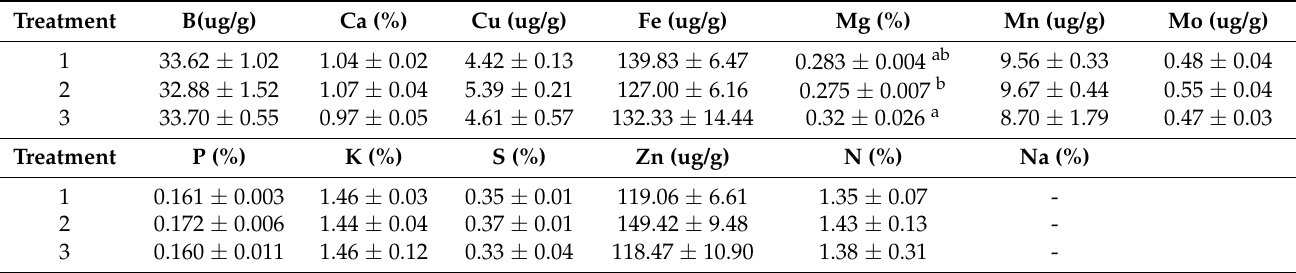
Table 6. Mean leaf tissue nutrient analysis ( ± SE) results by treatment in two-year-old balsam poplar trees. Significant differences between treatment means at p ≤ 0.05 are indicated by different letters. Treatment 1 = 25 selected tolerant clones, treatment 2 = 10 selected control clones, treatment 3 = Stream 1 vegetative lot clones.